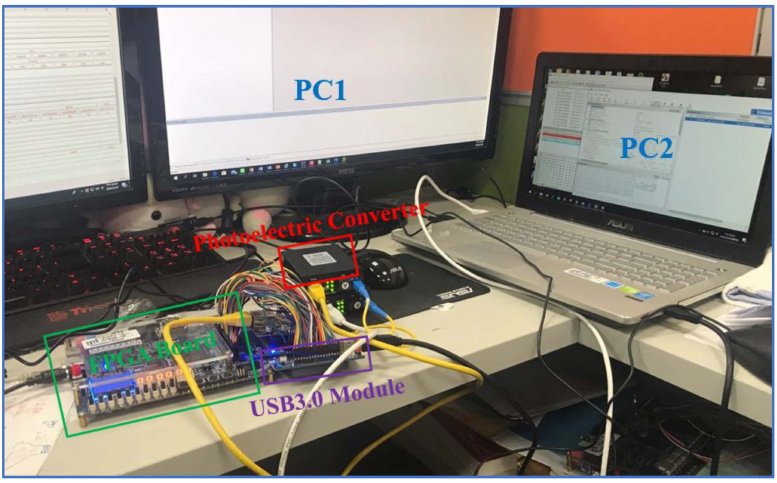
Figure 15. Verification architecture of the proposed packet transformation and transmission